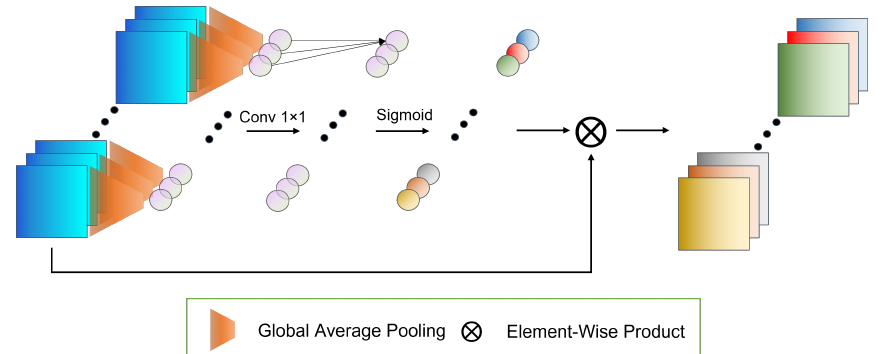
Figure 2. Visual representation of the channel attention module (CA-Module). Aggregated features are processed by average pooling to acquire the element for each channel. Channel weights are obtained after 1-D convolution and applying the sigmoid function. Corresponding channel weights and feature channels are shown in the figure by matching